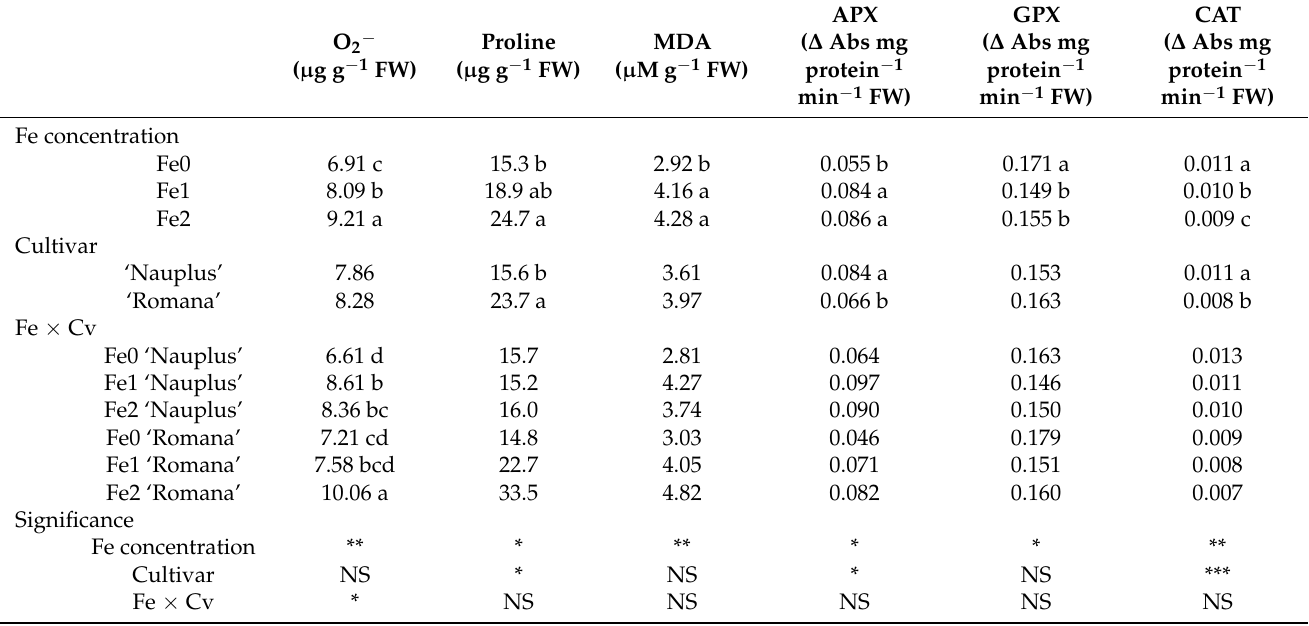
Table 2. Oxidative stress indicators and enzyme activity in lettuce, as affected by the studied factors.